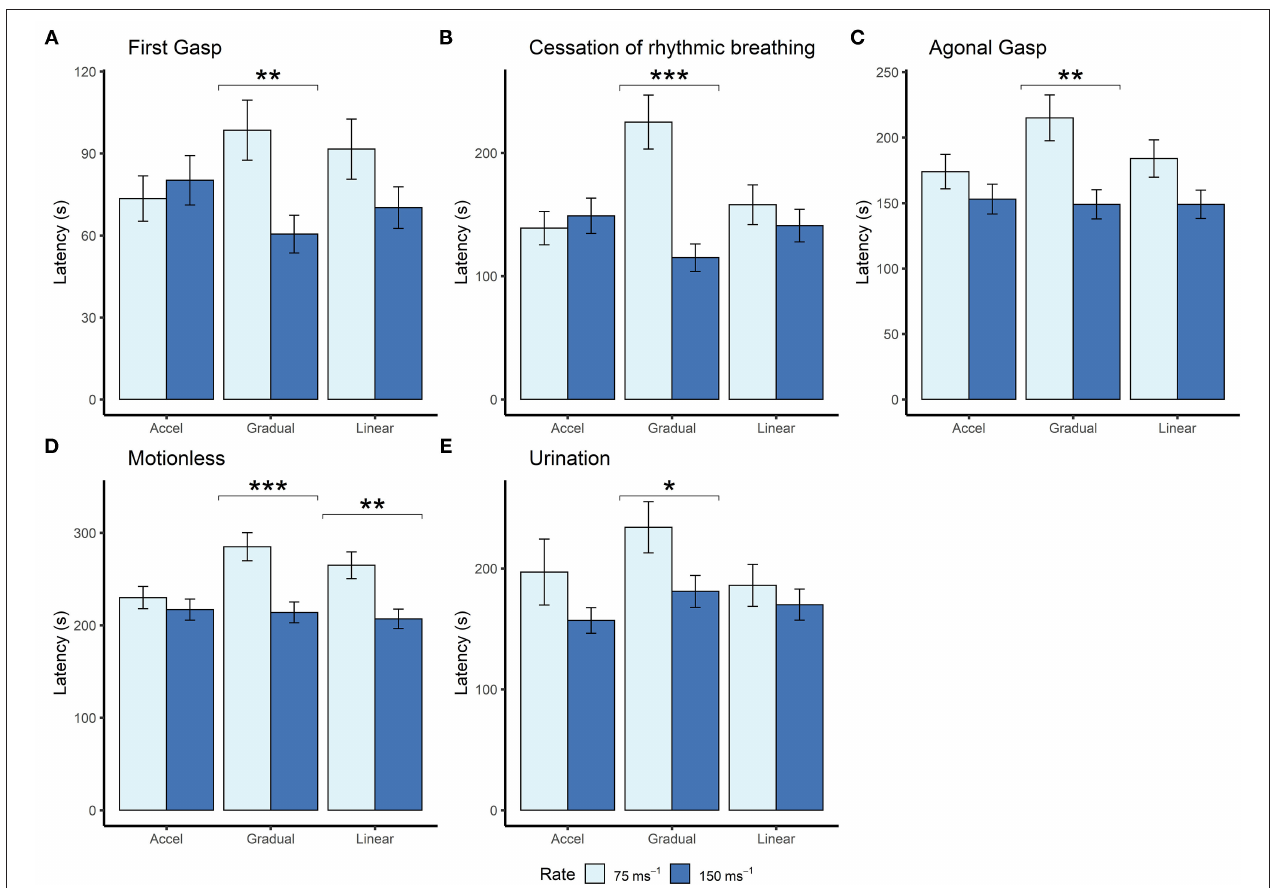
FIGURE 4 | Mean ( ± SE) latencies to (A) first gasp ( n = 12 per profile, n = 13 linear 150ms − 1 , n = 11 linear 75 ms − 1 ), (B) cessation of rhythmic breathing ( n = 12 per profile, n = 13 linear 150 ms − 1 , n = 11 linear 75 ms − 1) , (C) agonal gasping ( n = 12 per profile, n = 13 linear 150 ms − 1 , n = 11 linear 75 ms − 1 , n = 10 gradual 75 ms − 1 ), (D) motionless ( n = 12 per profile, n = 13 linear 150 ms − 1 , n = 11 linear 75 ms − 1 , n = 11 gradual 75 ms − 1 ), and (E) urination (linear 75 ms − 1 n = 5; linear 150 ms − 1 n = 6; accelerated 75 ms − 1 n = 3; accelerated 150 ms − 1 n = 9; gradual 75 ms − 1 n = 6; gradual 150 ms − 1 n = 6) according to decompression rate [75 ms − 1 (light blue) and 150 ms − 1 (dark blue)]. * p < 0.05, ** p < 0.01, *** p <